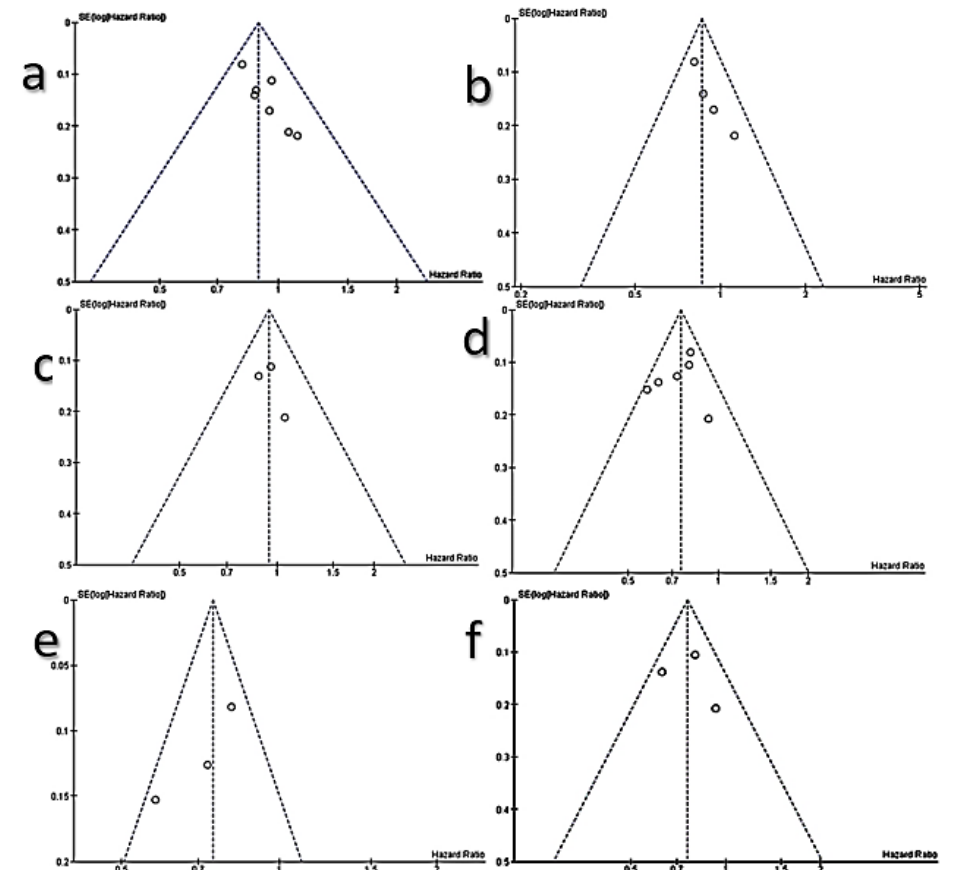
Figure 3. Funnel plots of publication bias; ( a ): overall survival in all RCTs, ( b ): OS in NSCLC RCTs, ( c ): overall survival (OS) in head and neck squamous cell carcinoma (HNSCC) RCTs, ( d ): progression-free survival (PFS) in all RCTs, ( e ): PFS in non-small cell lung cancer (NSCLC) RCTs, ( f ): PFS in HNSCC RCTs.